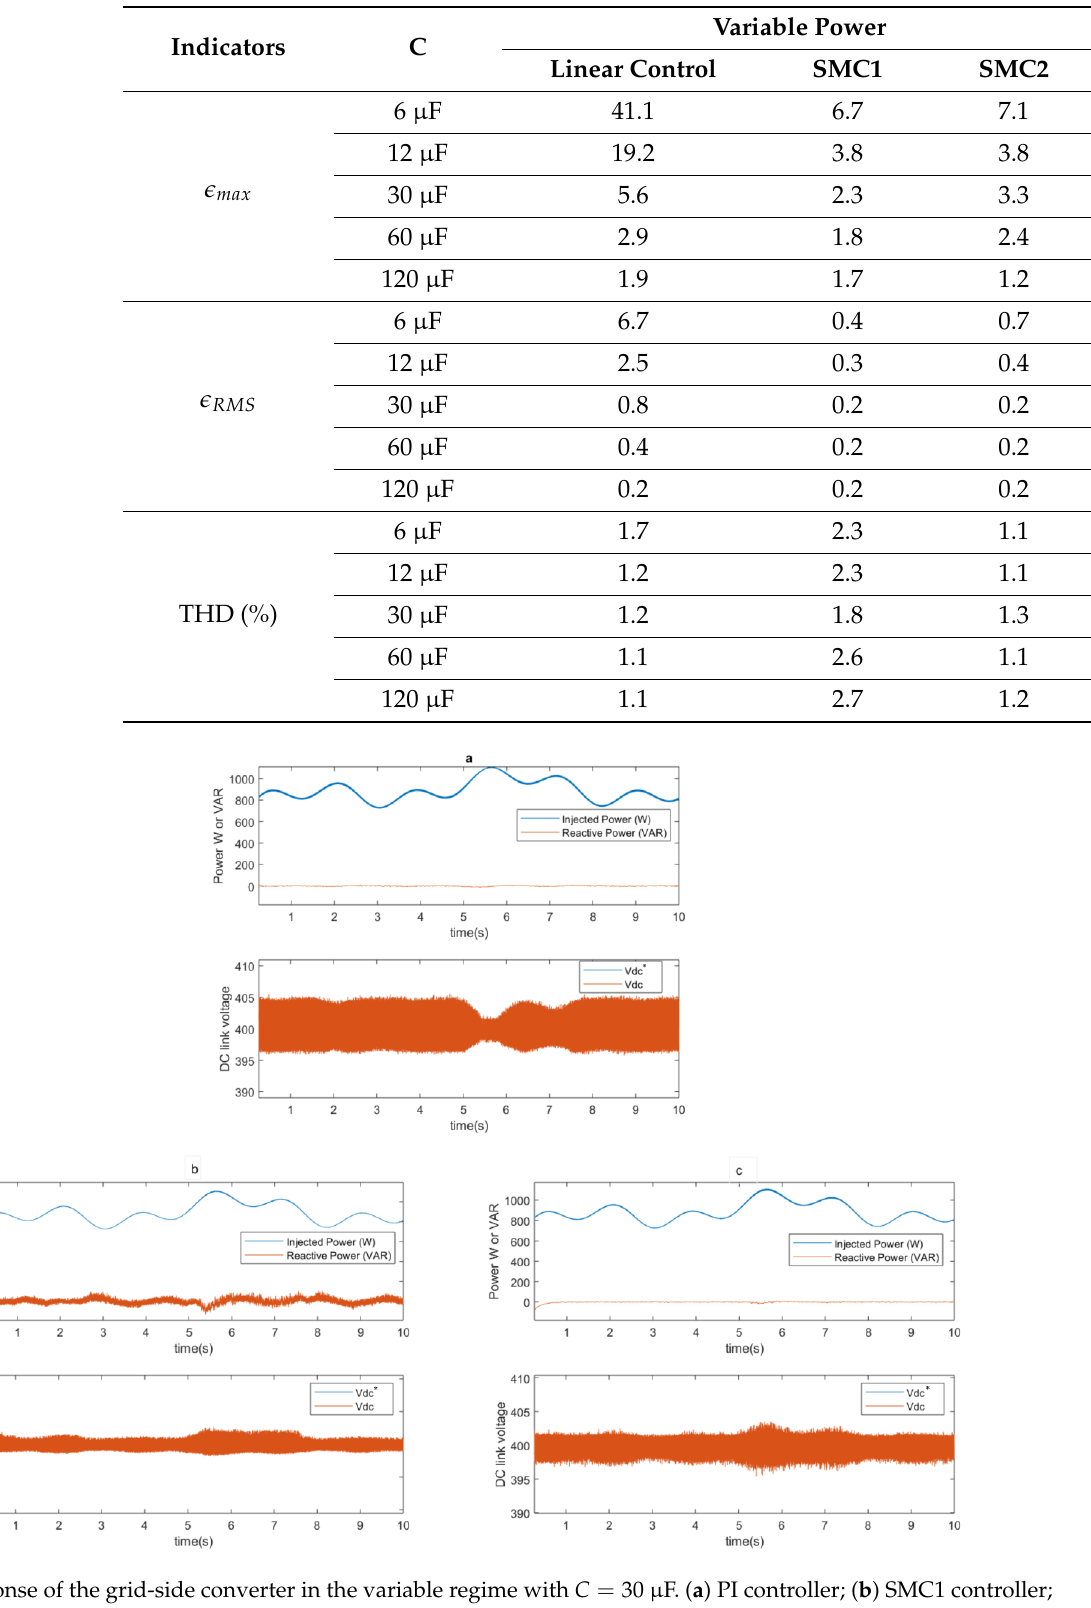
Table 4. Comparison of the errors, (cid:101) max and (cid:101) RMS , and the THD line current obtained by the three algorithms in the case of variable power.